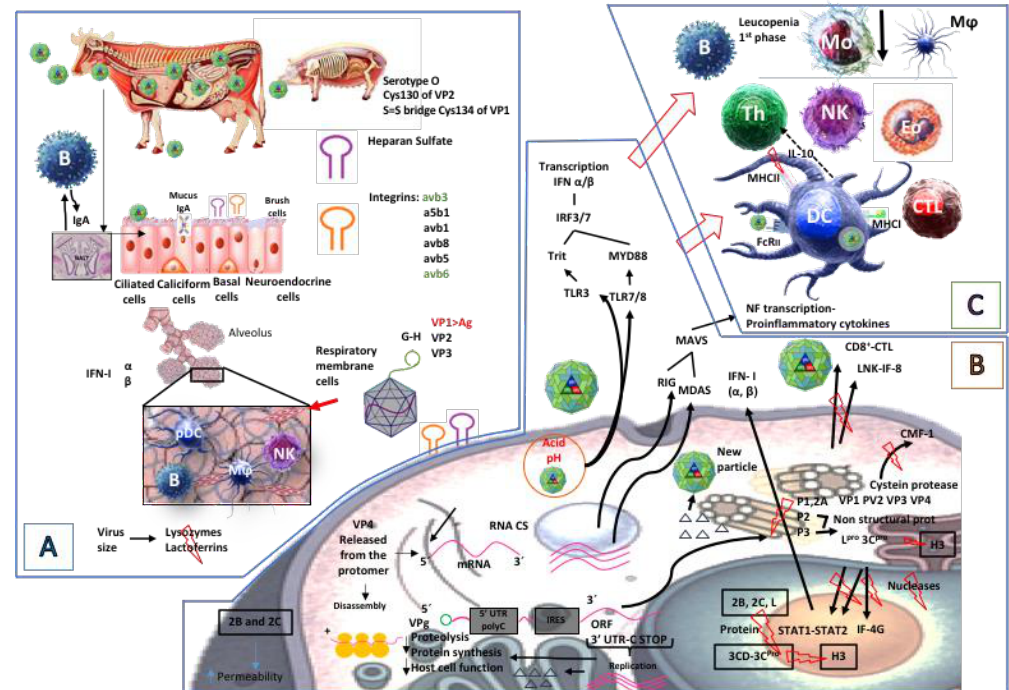
Figure 4. Foot-and-mouth disease virus mechanisms for evading an immune response. ( A ) FMDV enters the airways, taking advantage of its small size which seems to enable it to evade the airways’ lysozymes and lactoferrins. It enters the epithelial cells by receptor-mediated endocytosis: i.e., integrins and heparan sulphate (HS). Capsid protein viral polypeptide 1 (VP1) is the most antigenic viral protein; a region in this polypeptide’s G-H loop consists of 140 to 160 aa; it has been identified as the predominant epitope stimulating nAb production by B-cells. Comparing the structures of various FMDV serotypes has shown that the main differences regarding formation are produced in VP1, VP2, and VP3 loop and C-terminal region, thereby contributing to the virus’ antigenic variation. Dynamic simulations of FMDV’s molecular structure have revealed that the G-H loop protrudes from the capsid’s surface and actively fluctuates as a tentacle in its natural state, suggesting that such “flexibility” could ensure the virus’ correct binding to Abs and cell receptors. The VP2 polypeptide’s Cys 130 region of the virus’ O serotype could covalently bind to VP1 Cys 134 region using a disulphide bond for increasing the extent of variation in the VP1 loop. ( B ) The endosome’s low pH promotes the viral genome’s stripping and release which becomes translocated to host cell cytosol. Positive-sense genomic RNA (gRNA) functions as messenger RNA (mRNA); it has the VPg protein at the 5′ extreme, followed by the 5UTR region with the PolyC region and internal ribosome entry site (IRES) which binds to the ribosomes, followed by the open reading frame (ORF). The 3UTR region and the PolyA tail are at the 3′ extreme. Proteinase L (L pro ) and P1, P2, and P3 polypeptides are released by viral polyprotein processing by proteolytic cleavage; P1 encodes structural proteins VP1, VP2, VP3, and VP4 which assemble to form the viral capsid. P2 encodes three non-structural proteins: 2A, 2B, and 2C. P3 encodes four non-structural proteins: 3A, 3B, 3C, and 3D. 2B and 2C expression is related to blocking host cell protein secretion and greater permeability of their plasmatic membrane. L pro promotes rapid replication of the viral genome, inactivates (eIF-4G) host cell mRNA translation, inhibits host cell protein synthesis, blocks IFNα and IFNβ expression and promotes viral protein synthesis thereby reducing host cell ability to develop an antiviral response. Viral proteins P3C pro or 3C pro are related to cell protein cleavage in infected cell cytoplasm, induce H3 cleavage, lowering host cell mRNA levels. When 3CD or 3Cpro are found in host cell nucleus this inhibits H3, reducing host cell mRNA synthesis even more so. This could also impede IFN I signalling by altering STAT 1 and STAT 2 nuclear translocation, affecting antiviral effectors and immunostimulatory genes. ( C ). It has been estimated that FMDV also a ff ects the mechanism for antigen presentation by DCs and monocytes; these cells increase IL-10 production, reduce MHC II expression which decreases antigen processing by these